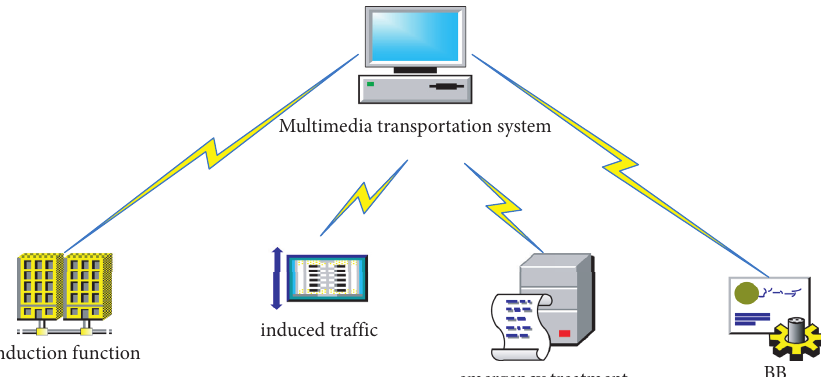
Figure 1: Multimedia transportation